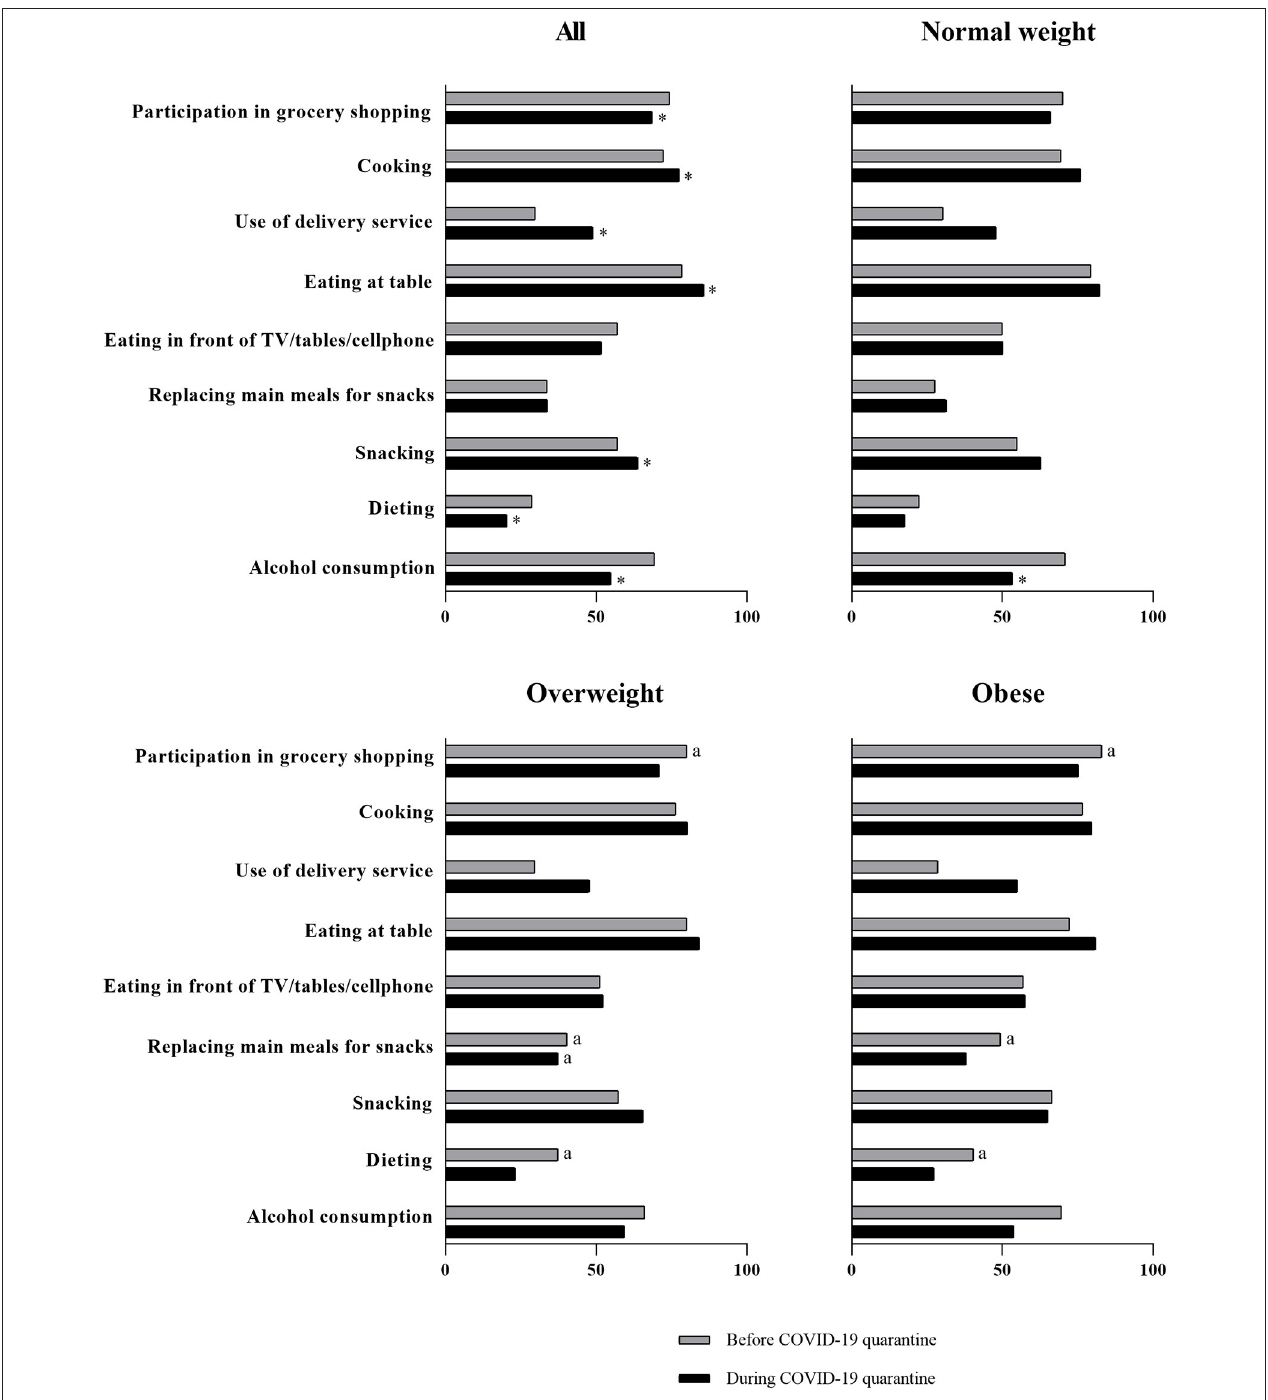
FIGURE 1 | Changes in eating habits during the COVID-19 quarantine among Brazilian women. Data are presented as frequency (n [%]) for the presence of the habit; * p < 0.05 vs. before COVID-19 quarantine. a p < 0.05 vs. normal weight.